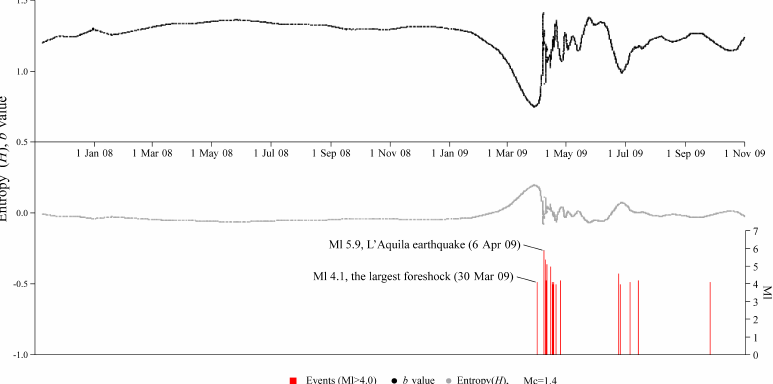
Figure 10. Time series of b value (above plot), Shannon entropy ( H ; intermediate plot), and seismic events (Ml ≥ 4.0; bottom plot) during phases P1-2 and P2.